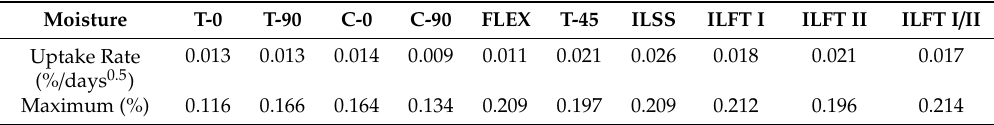
Figure 1. Conditioning curves for test types considered; the exposure time is expressed in square root of days. Table 2. Moisture uptake parameters extracted from conditioning curves.